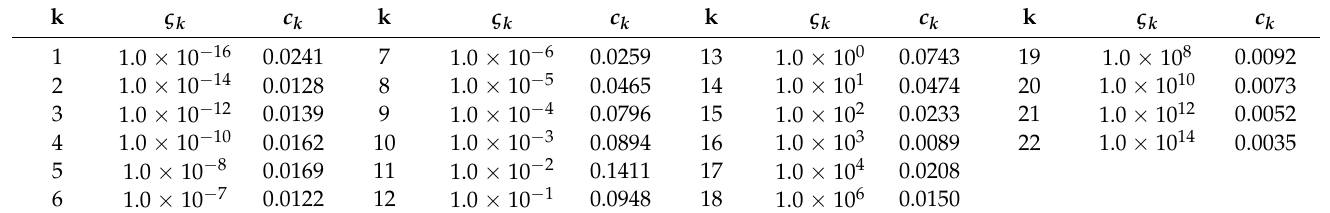
Table 1. Fitted values of weighting coefficients and relaxation times.